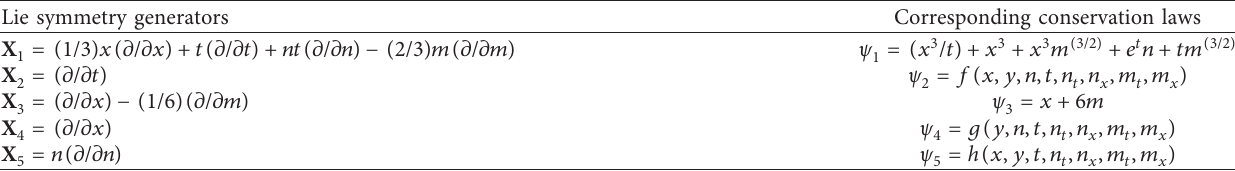
Table 5: Lie symmetry generators and corresponding conservation